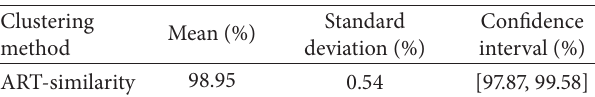
Table 4: Statistical performance of ART-similarity clustering method.